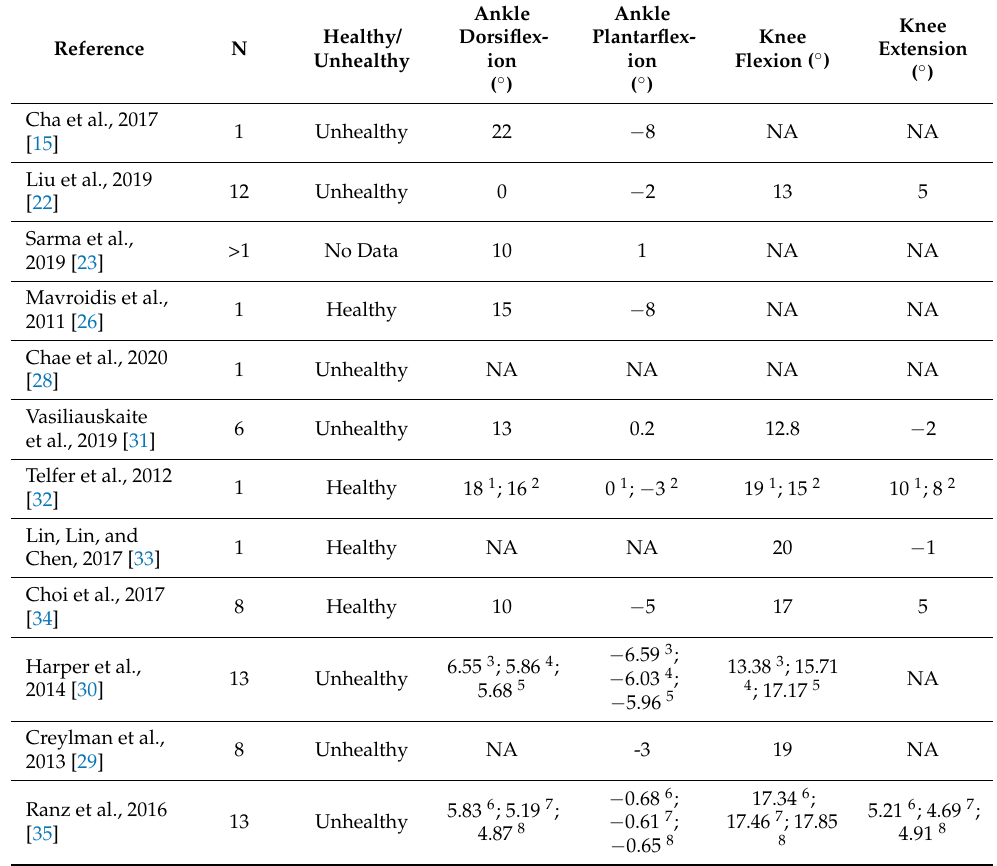
Table 3. Comparison between the different maximum angles obtained by the ankle and knee of the leg with the AFO at the stance